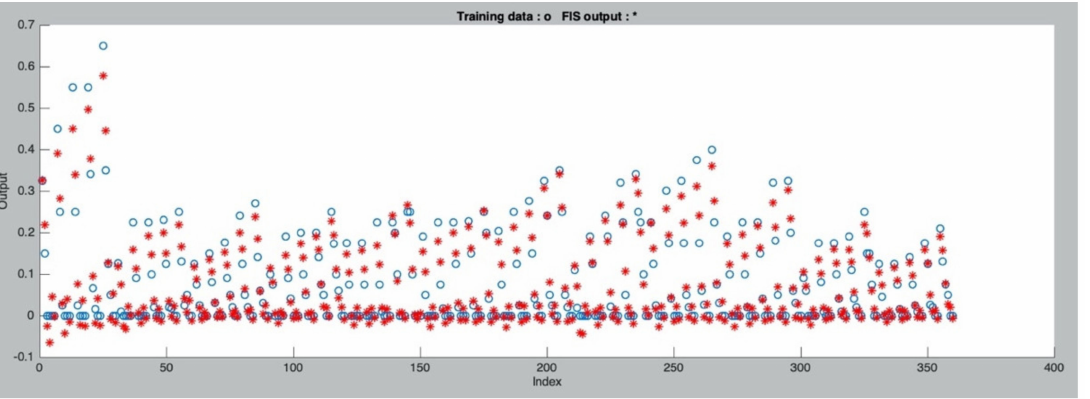
Figure 17. Performance of training